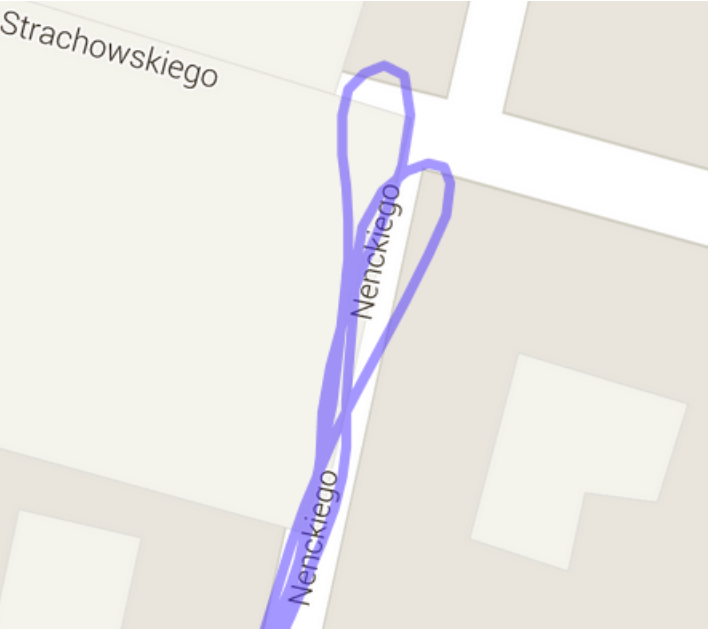
Figure 3. GNSS receiver inaccuracy: turning around in the same place (Garmin watch